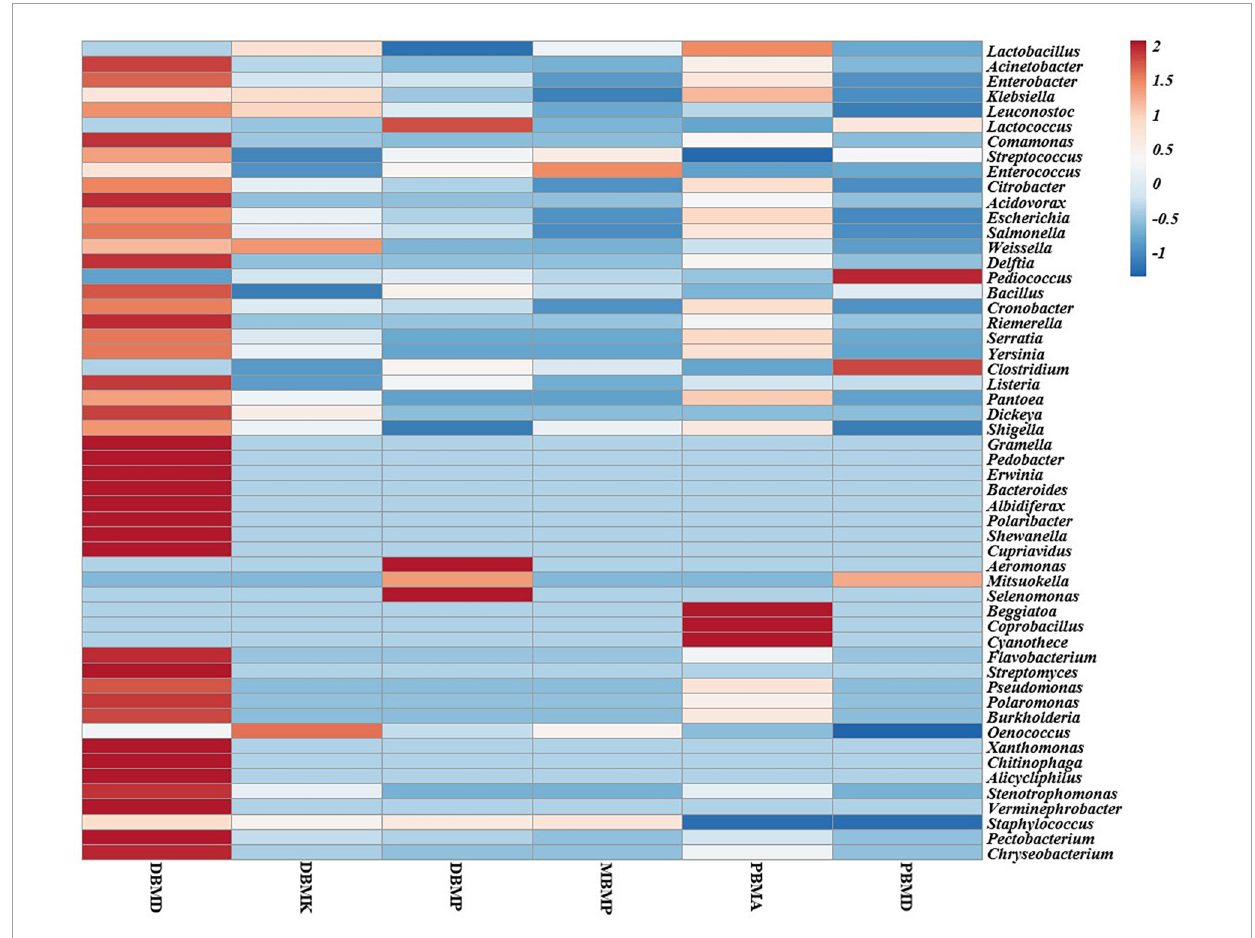
FIGURE3 Heat map representation of major bacterial genera in moiya pangsung, mileye amileye, moiya koshak, and midukeye .